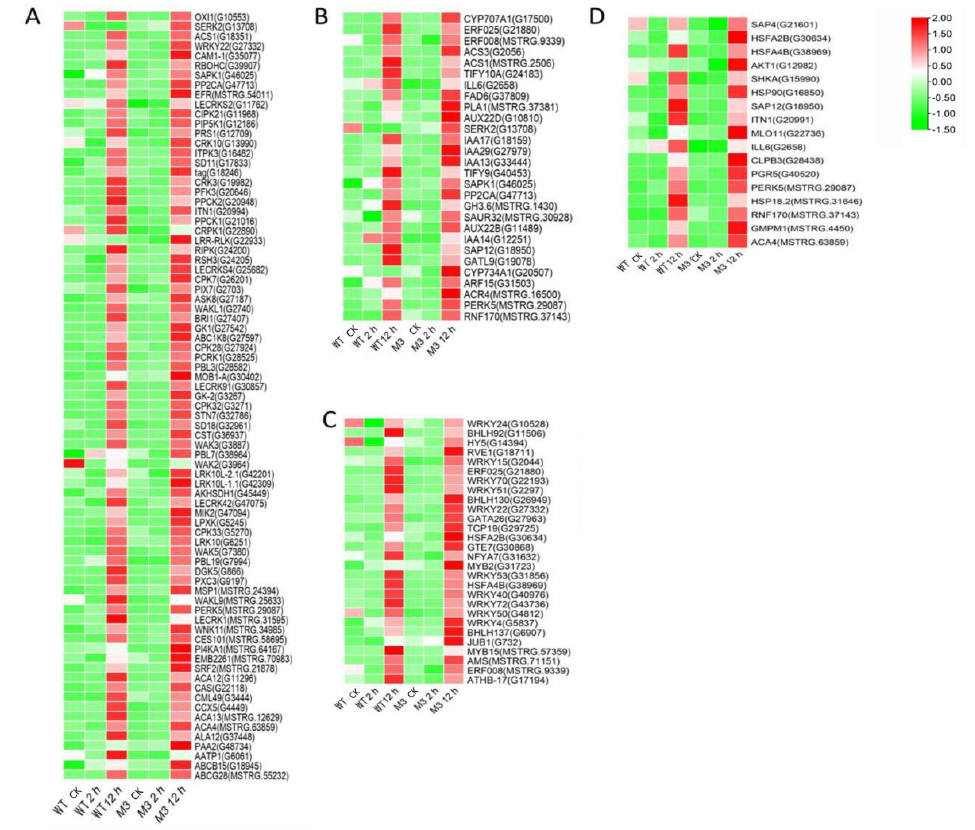
Figure 5. Heatmap of common DEGs involved in Profile 4 in both WT and M3 plants. ( A ) Protein kinase and Ca 2+ signal-related genes, ( B ) hormone-related genes, ( C ) transcription factors, and ( D ) stress-related genes were identified. The sample and treatments are displayed at the bottom of each column. Relative expression levels are shown by a colored gradient, from low (green) to high (red). Scale bars represent the log 2 transformations of the RPKM values.